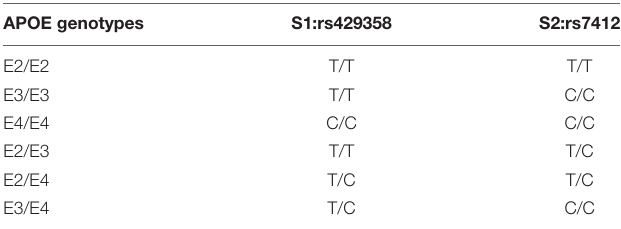
TABLE 1 | APOE genotyping is determined by promoter polymorphisms of two single nucleotides (rs429358 and rs